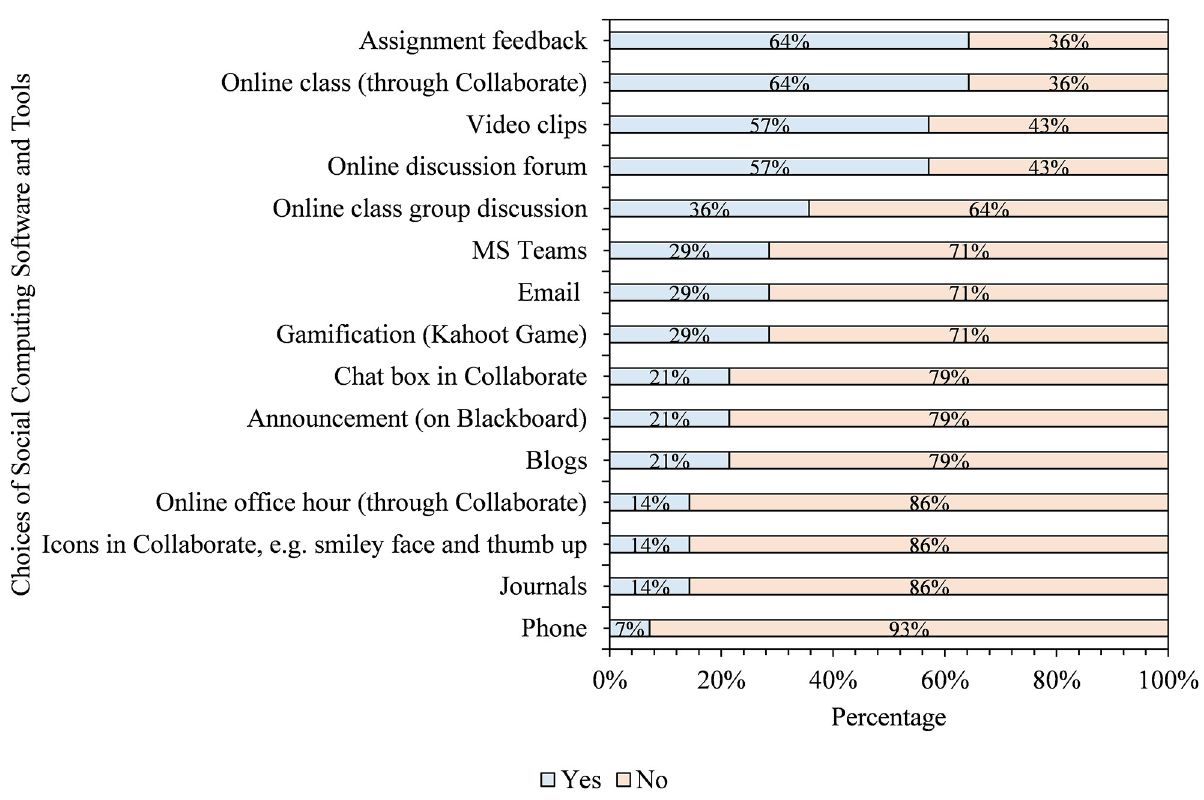
Fig 4. Arts, humanities and social sciences, and business students’ preference for online learning tools used in the course.